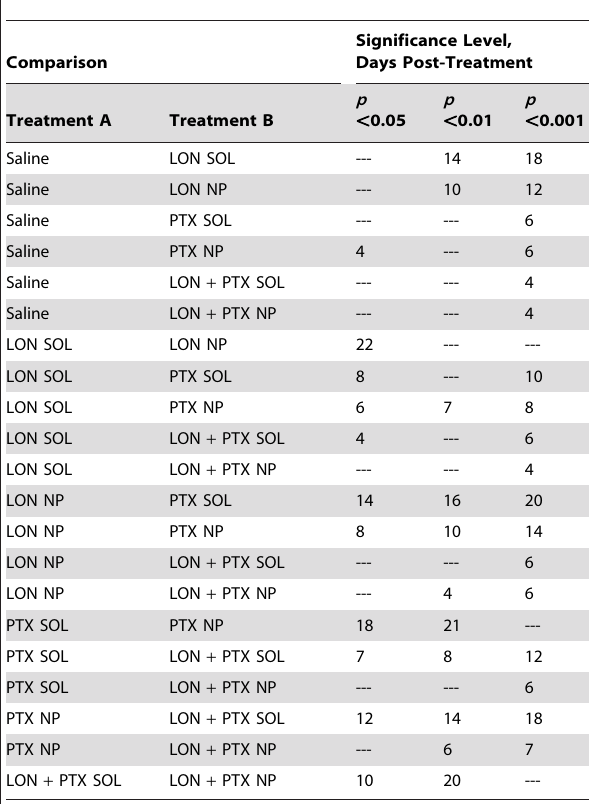
Table 1. Two-Way ANOVA of tumor growth.